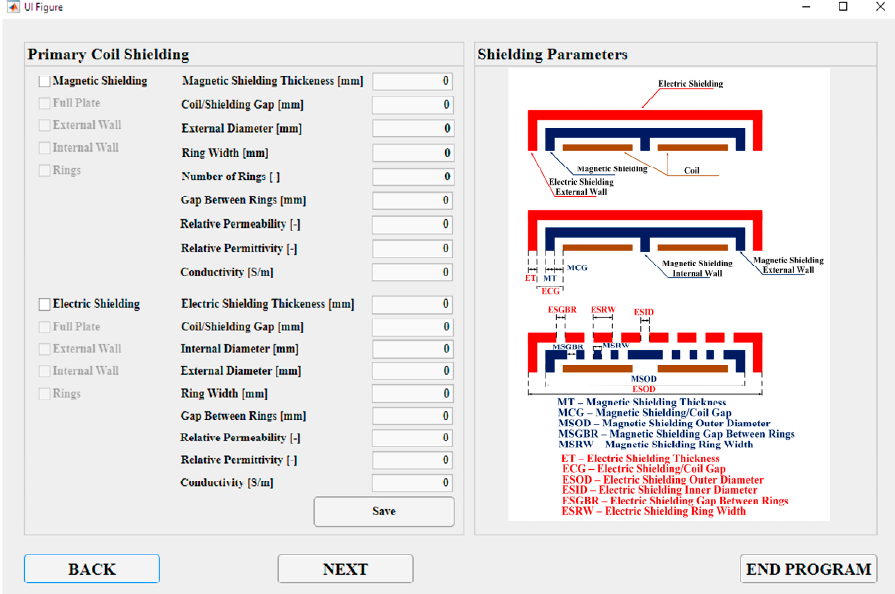
Figure 14. Display showing magnetic shielding parameters definition (top—left part) and display showing electric shielding parameters definition (bottom—left part).